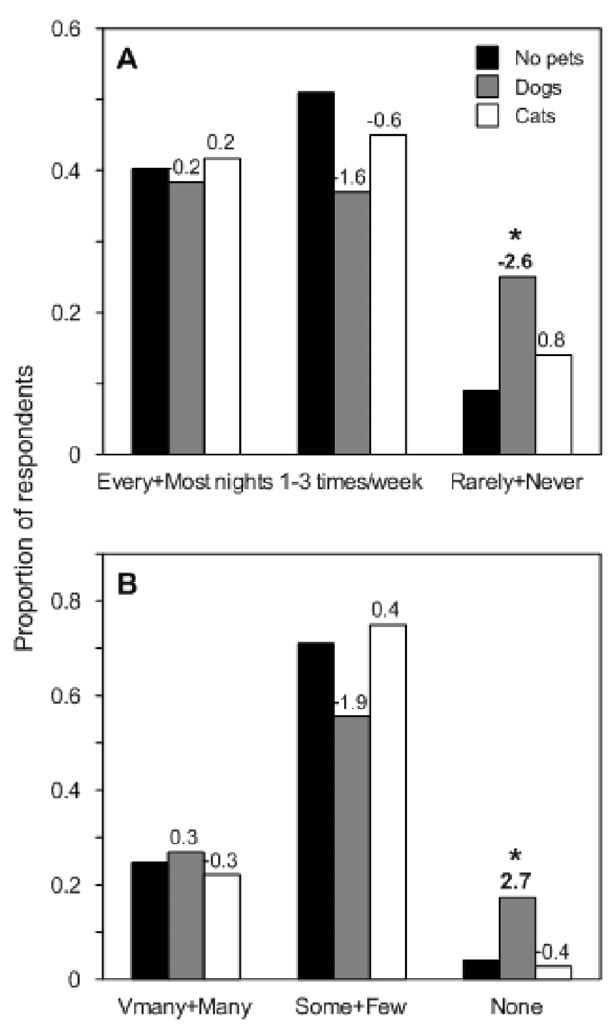
Figure 1. Typical frequency (A) and quantity (B) of diggings appearing in yards with each pet type. Dog owners were more likely to report rarely or never seeing fresh diggings (A), and seeing no new diggings (B). Data are proportions of survey respondents choosing each answer. Numbers above the bars are adjusted standardized residuals from the contingency analysis of each question for dogs versus no pets and cats versus no pets. Residuals greater than two indicate a lack of fit of the null model in that cell (denoted by asterisks). Negative residuals indicate a smaller proportion choosing that answer, and positive residuals indicate a greater proportion choosing that answer than expected if factors were independent.